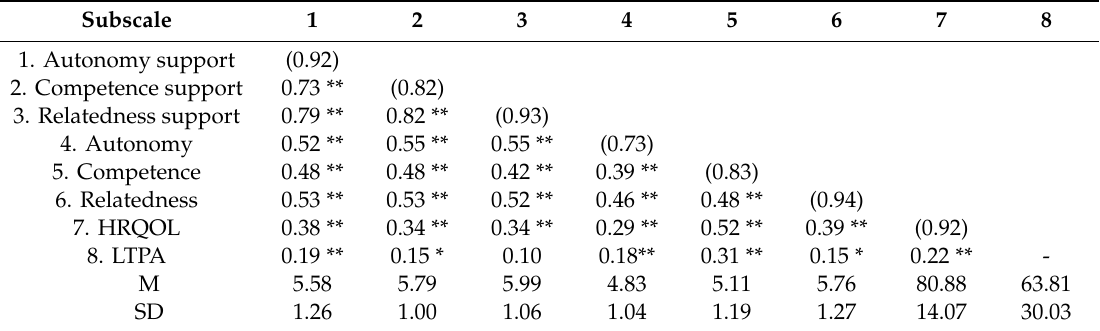
Table 1. Descriptive Statistics, Internal Consistency, and Correlations among the Study Variables (N =